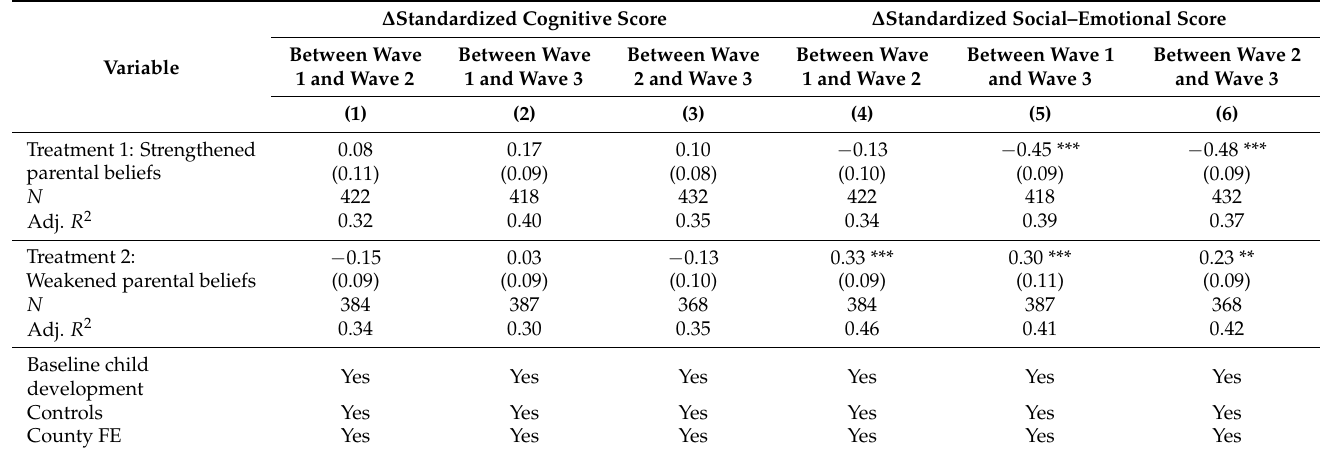
Table 8. DIDM analysis of the effect of strengthened and weakened parental beliefs on child develop- mental